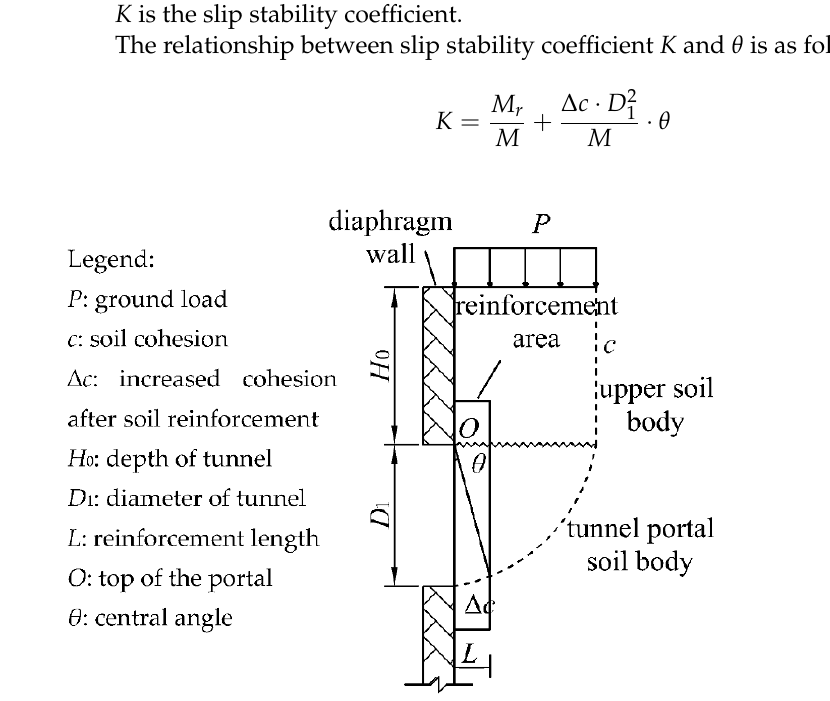
Sliding moment M ,